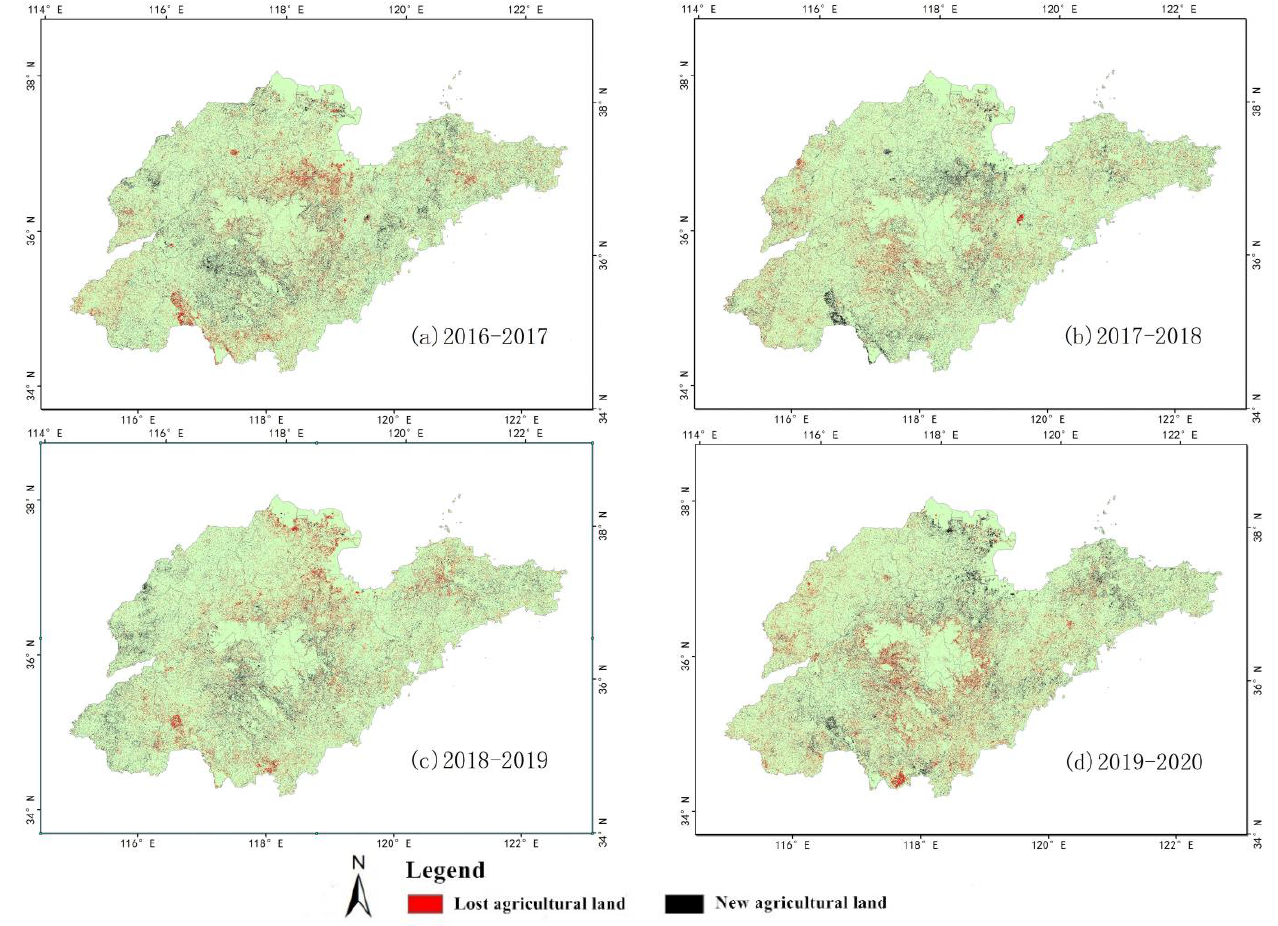
Figure 10. Information on agricultural land use changes in Shandong Province, 2016 – 2020. ( a ) Monitoring results of agricultural land change in Shandong Province during 2016 – 2017; ( b ) Monitoring results of agricultural land change in Shandong Province during 2017 – 2018; ( c ) Monitoring results of agricultural land change in Shandong Province during 2018 – 2019; ( d ) Monitoring results of agricultural land change in Shandong Province during 2019 – 2020.